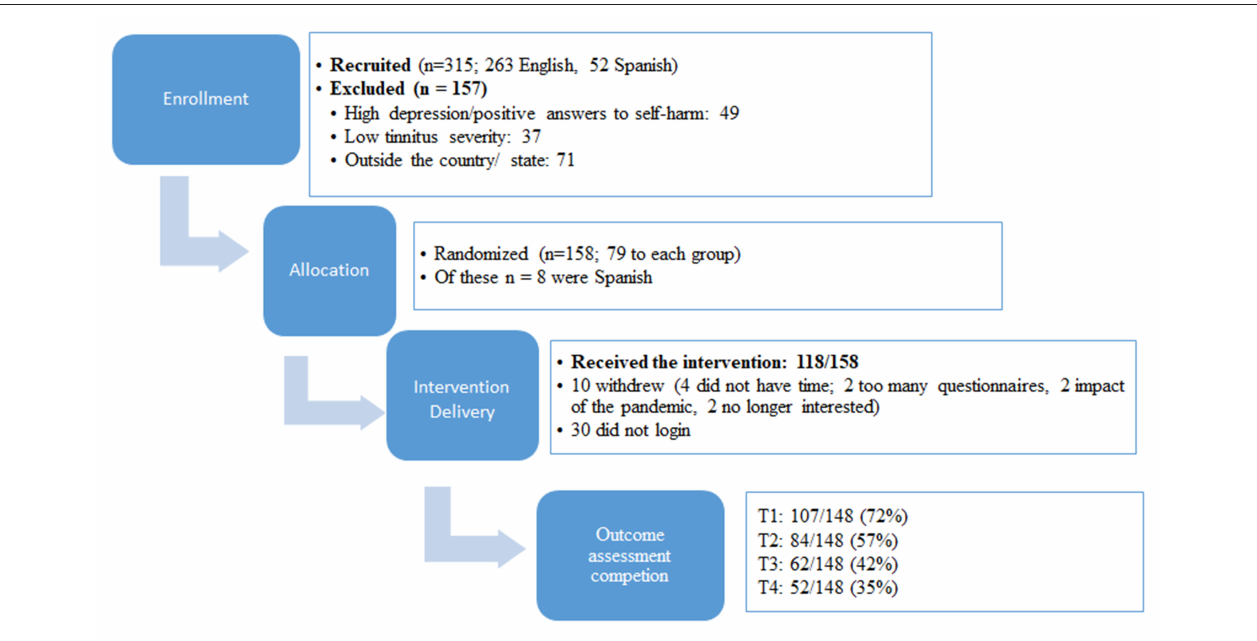
FIGURE 1 | Flowchart of enrollment, allocation, intervention delivery, and outcome assessment completion. T1 is after the experimental group received the treatment, T2 after the control group received the treatment, T3 is at 2 month follow-up, and T4 is at 1 year follow-up.